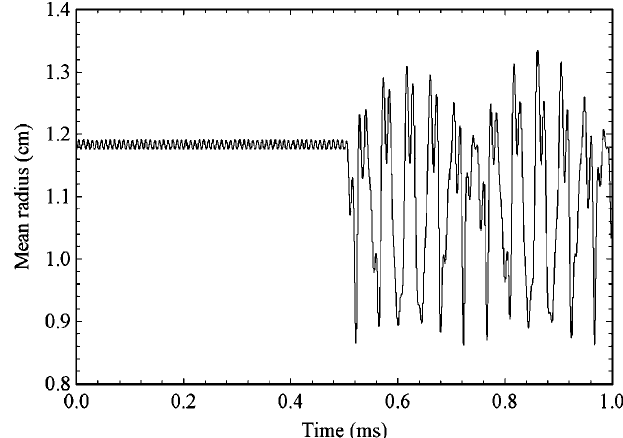
p FIG. 6. The mean radius (cid:1)(cid:1)(cid:1)(cid:1)(cid:1)(cid:1) ab undergoes large-amplitude os- cillations that do not correspond to a matched-beam solution of the coupled envelope equations when an instantaneous decrease in the frequency _ (cid:7) (cid:6) t (cid:7) = 2 (cid:1) from 60 to 45 kHz to compress the charge bunch is made.